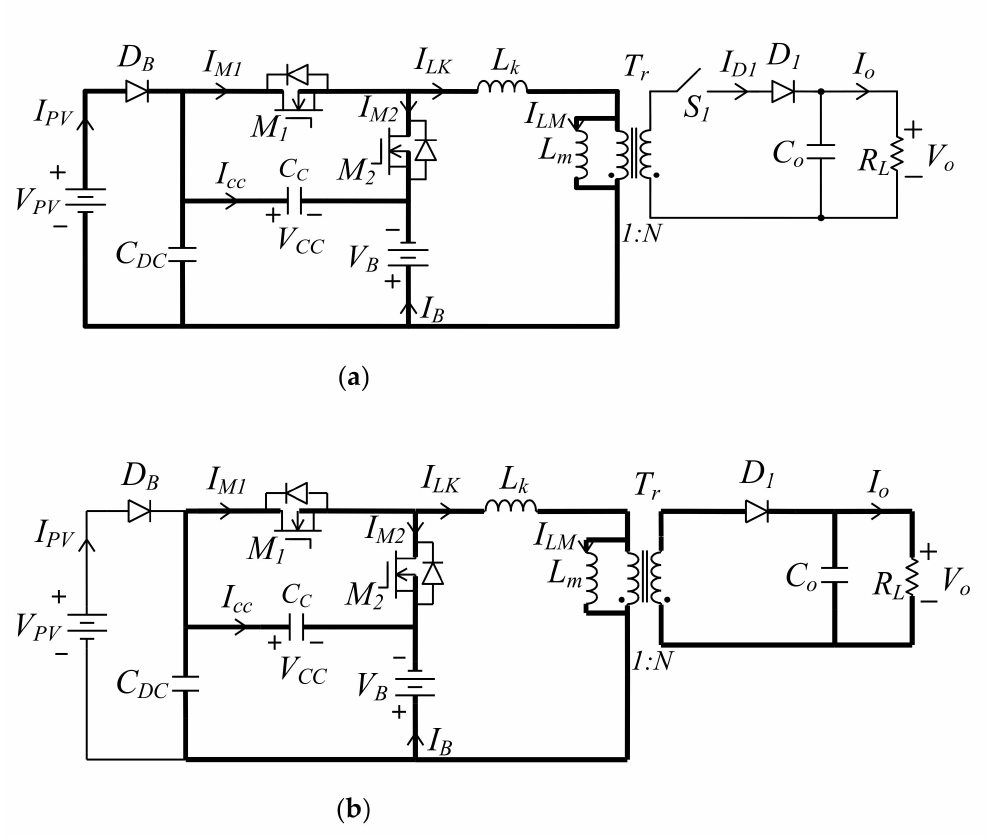
Figure 7. Schematic diagram of the proposed hybrid converter operated in ( a ) the charging mode, and ( b ) the discharging